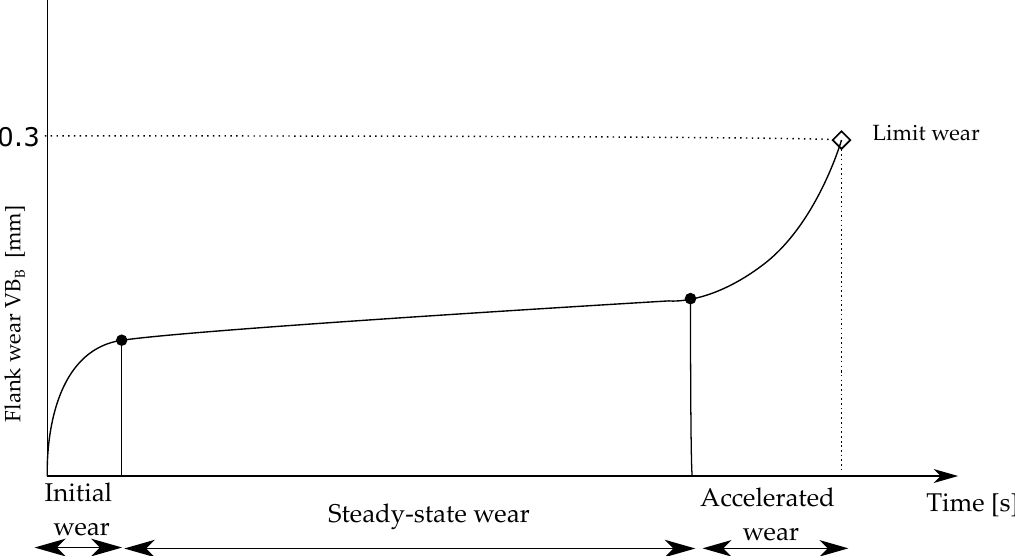
Figure 1. Tool life for a given cutting